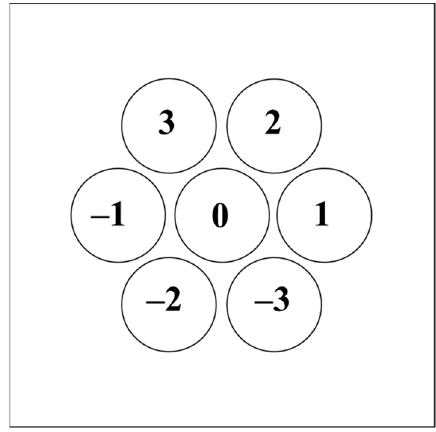
Figure A1. Emissive plane and element index in the 7-element system. Table A1. Coordinates of sub-apertures on the emissive plane in the 7-element system.